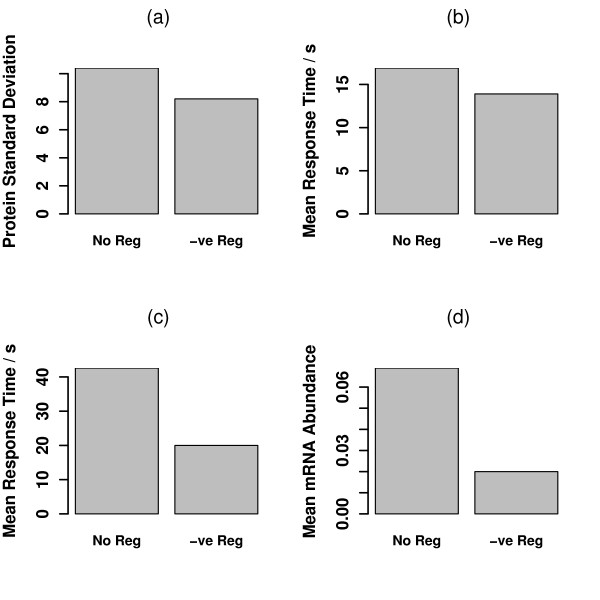
In Silico Evolution. Simulations of the bestmodels derived from in silico evolution of the systemwithout regulation and the system with negative feedback. (a) Evolution to minimize protein standard deviation. The regulated system can achieve about 21% improvement over the unregulated system, with the standard deviation reduced from 10.4 to 8.2 for a protein abundance of 100 molecules per cell. The evolved parameters for the unregulated system are: km = 1.0s-1; kp = 0.00387s-1; γm = 0.0664s-1; γp = 0.000572s-1. The evolved parameters for the negatively regulated system are: koff = 0.256s-1; km = 0.835s-1; kp = 0.294s-1 γm = 1.783s-1; γp = 000282s-1. (b) Evolution to minimize first passage time to 50% of mean protein abundance. The regulated system only achieves an improvement of 18% over the unregulated system with the rise time (of 20 repeats of the best model) reduced from 16.9s to 13.9s. The evolved parameters for the unregulated system are: km = 1.0s-1; kp = 1.0s-1; γm = 0.0591s-1; γp = 0.163s-1. The evolved parameters for the negatively regulated system are: koff = 0.0664s-1; km = 1.0s-1; kp = 1.0s-1; γm = 0.0494s-1; γp = 0.0146s-1. (c) Evolution to minimize first passage time to mean protein abundance. The regulated system achieves an improvement of 53% over the unregulated system with the rise time (of 20 repeats of the best model) reduced from 42.6s to 20.0s. The evolved parameters for the unregulated system are: km = 0.903s-1; kp = 1.0s-1; γm = 0.101s-1; γp = 0.0916s-1. The evolved parameters for the negatively regulated system are: koff = 0.000648s-1; km = 1.0s-1; kp = 1.0s-1; γm = 0.00139s-1; γp = 0.0183s-1. (d) Evolution to minimize mRNA usage. The regulated system is able to achieve a 71% improvement over the unregulated system, reducing mean mRNA levels from 0.069 to 0.020 molecules per cell to achieve a protein abundance of 100 molecules per cell. The evolved parameters for the unregulated system are: km = 0.000641s-1; kp = 0.468s-1; γm = 0.0148s-1; γp = 0.000200s-1. The evolved parameters for the negatively regulated system are: koff = 0.0942s-1; km = 0.270s-1; kp = 1.0s-1; γm = 1.168s-1; γp = 0.000200s-1. Note that the systems that minimize noise and mRNA usage evolve stable proteins while the systems that minimize response times evolve more rapidly turned-over proteins.